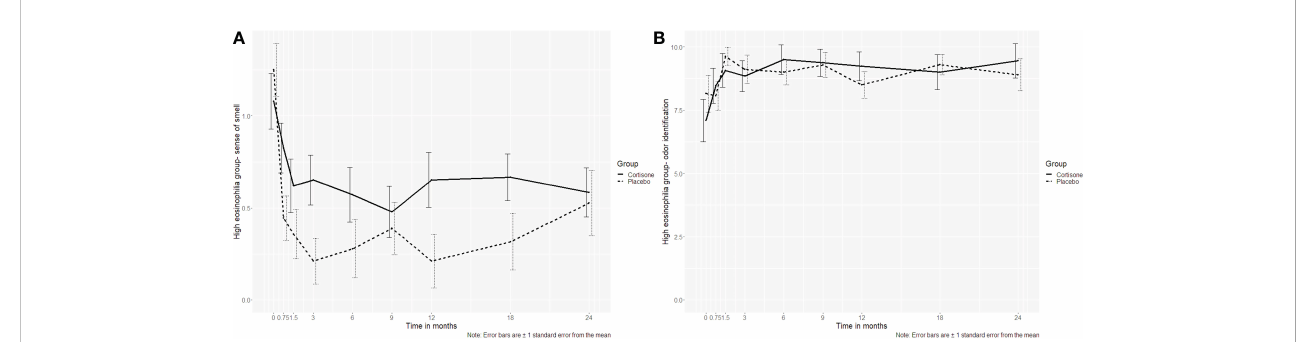
FIGURE 6 Line plots of the subgroup analysis (high eosinophilia in tissue group) for (A) the sinonasal symptom sense of smell and (B) the 16-item odor identi fi cation test assessed using Snif fi n´ Sticks. For the sinonasal symptom sense of smell, a signi fi cant interaction (p=0.034) was found with signi fi cant differences at the time points 0.75, 3 and 12 months (p=0.042; p= 0.020; p=0.040 respectively). However, after correction for multiple hypotheses testing, the signi fi cant differences did not hold. The objective counterpart, the 16-item identi fi cation test, did not show a signi fi cant difference either (p=0.168).